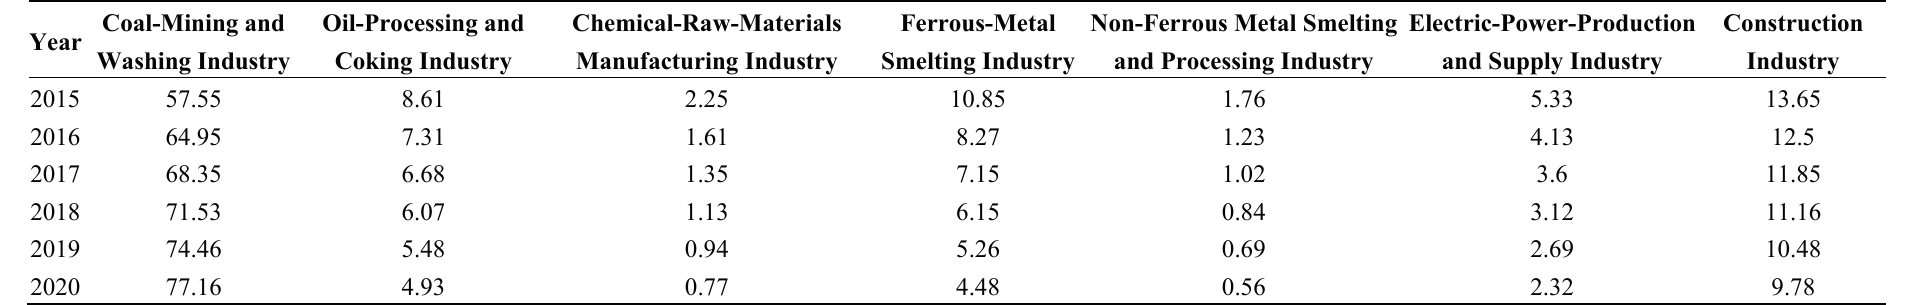
Table 22. Optimization design of the seven largest industries in terms of carbon emissions in the secondary industry in Shanxi province